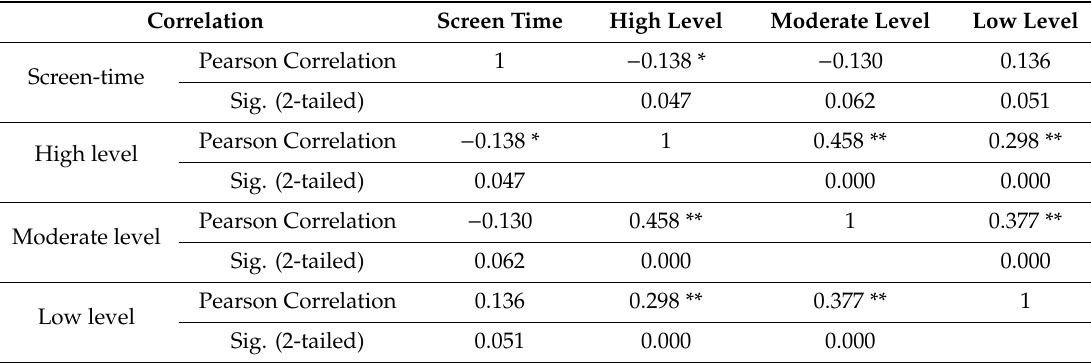
Table 2. Correlation between screen-time use and level of physical